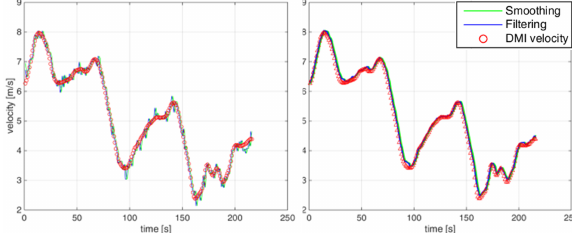
Figure 10. On the left the UKF augmented and on the right the not-augmented tangential velocities with 5 states Table 2. Delta mean and delta standard deviation between INS In Table 4 are shown the same results of the previous tables, but and UKF augmented or not-augmented applied to the motion related to the motion model with 6 states model with 4 states